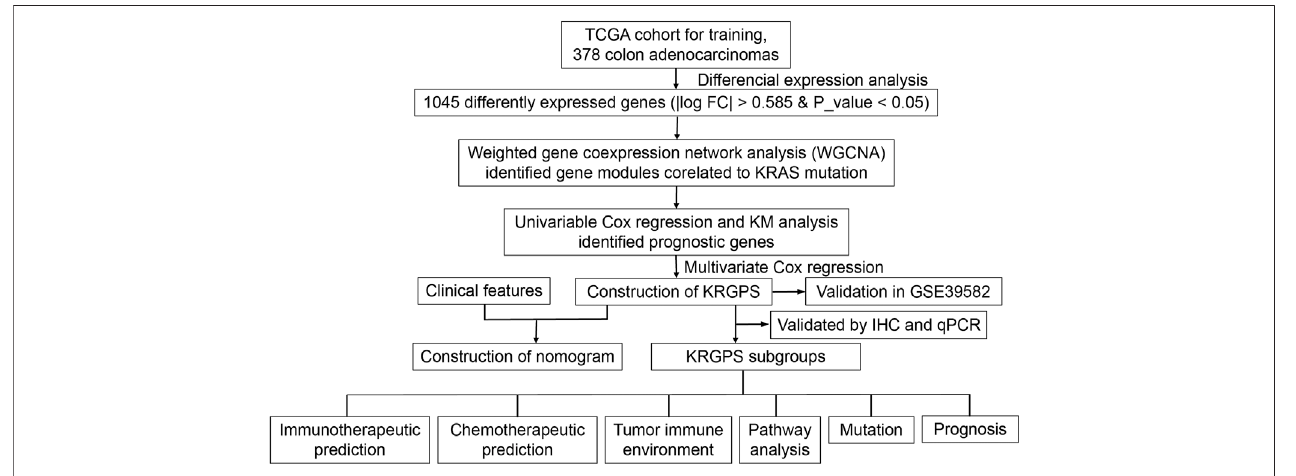
FIGURE 1 | Flow chart overview of the schedule performed to construct a prognostic gene model of colon adenocarcinoma.